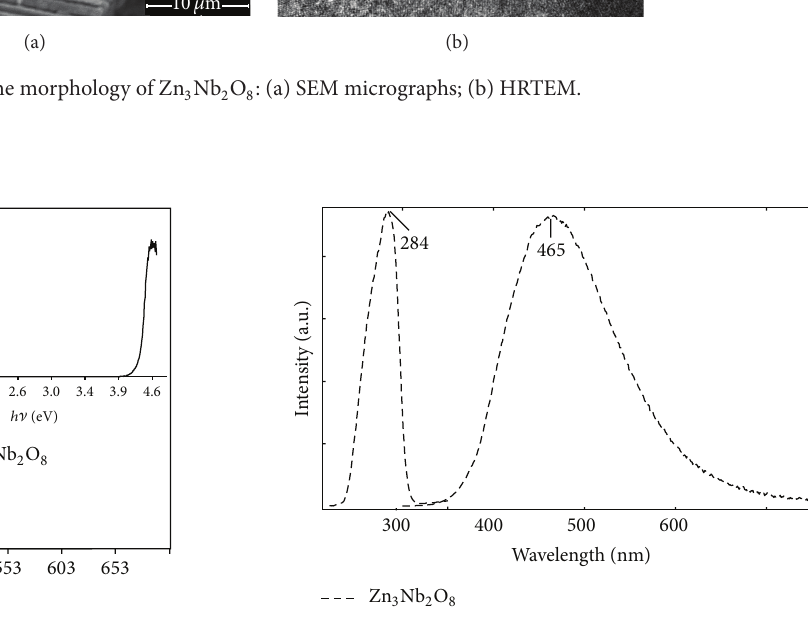
Figure 3: The absorption spectra of Zn 3 Nb 2 O 8 . Plot of {(𝑘/𝑠)ℎ ] } 2 versus ℎ ] (energy) of Zn 3 Nb 2 O 8 .